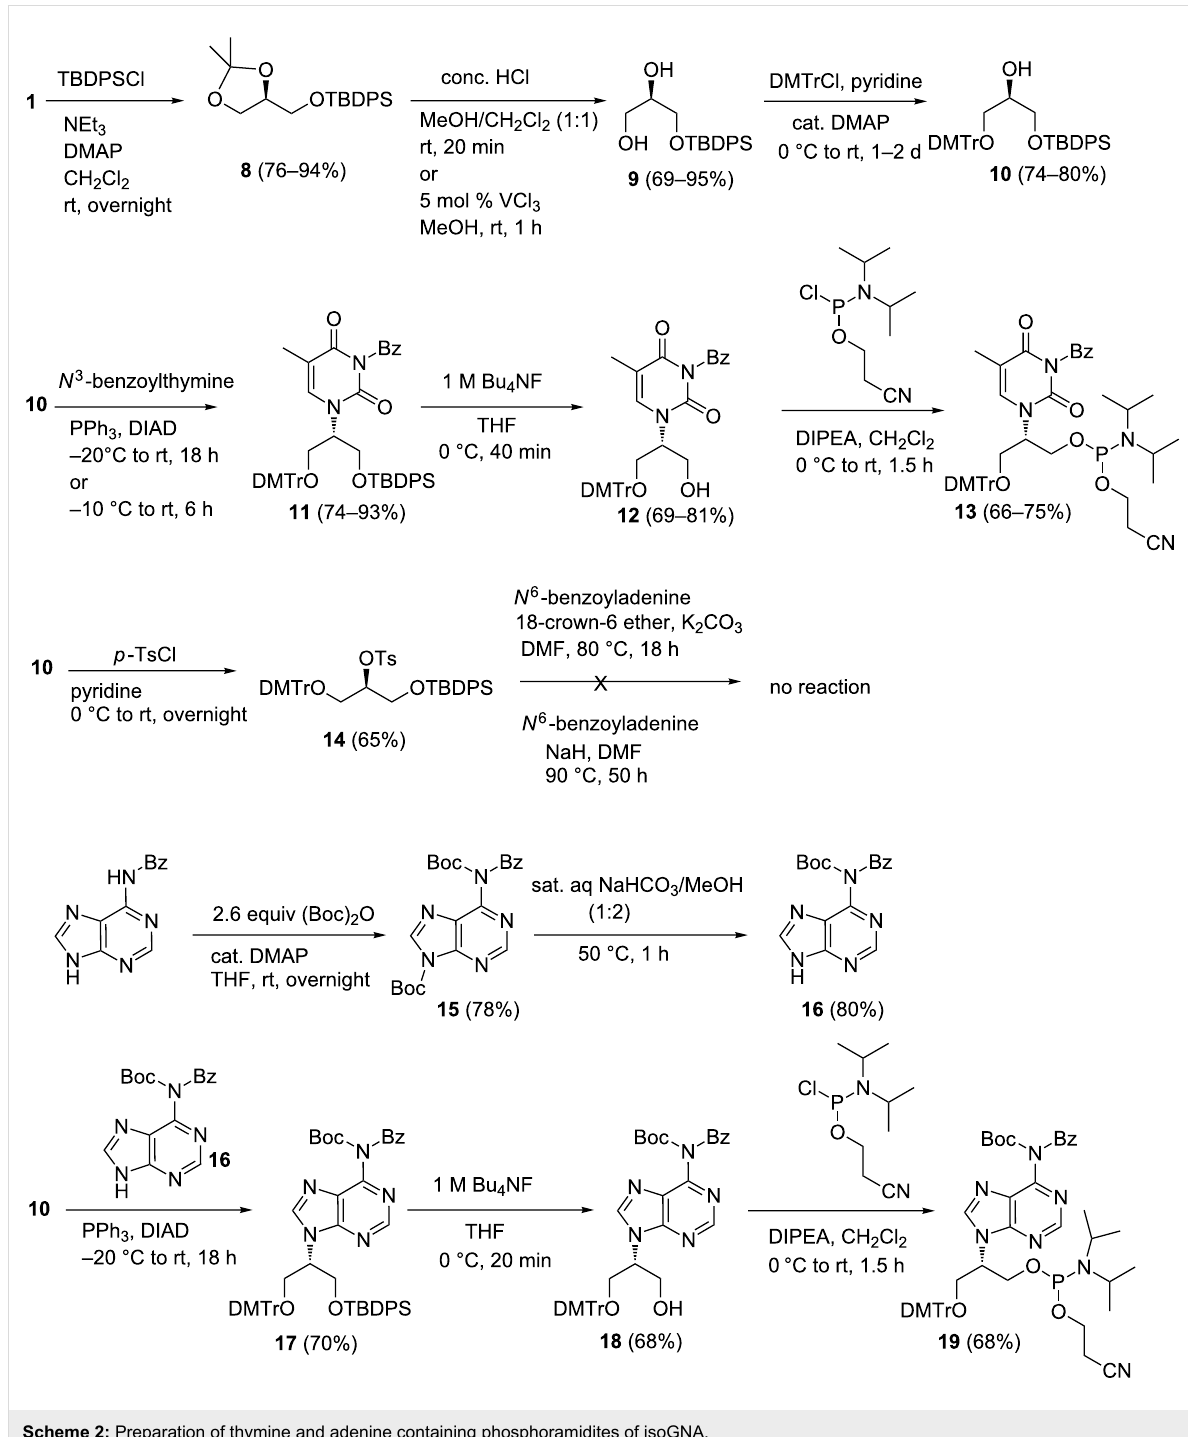
N 6 -benzoyladenine proved problematic and did not proceed even with the tosyl derivative 14 . The solubility issues with benzoylated adenine and the bulk of the O-TBDPS group may be the underlying reasons behind this difficulty. Therefore, we proposed to use a doubly N 6 -protected adenine, the N 6 -benzoyl-